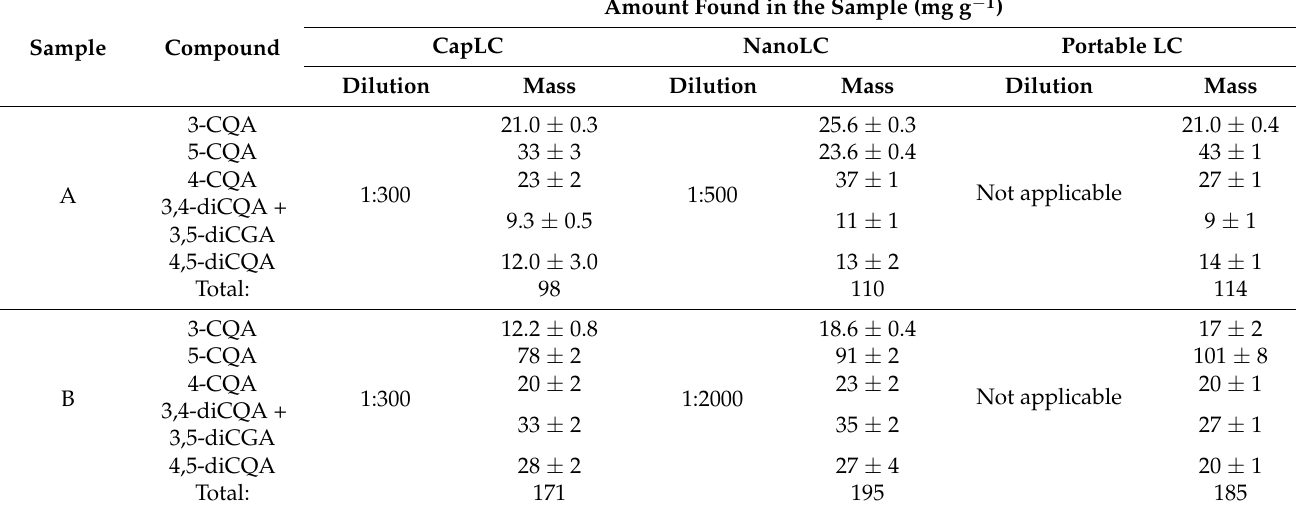
Table 3. Results obtained for the real samples analyzed (n =